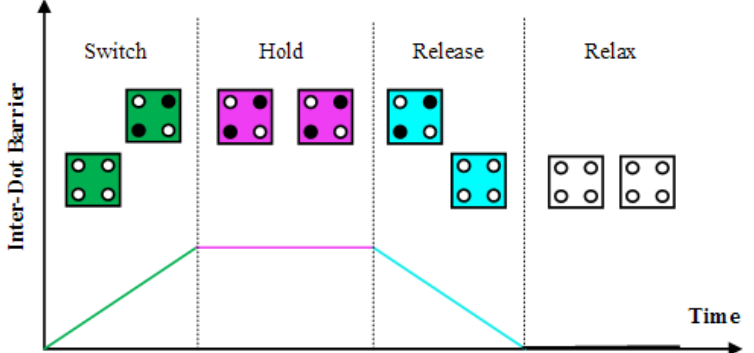
Figure 2. Clocking in QCA [7,8]